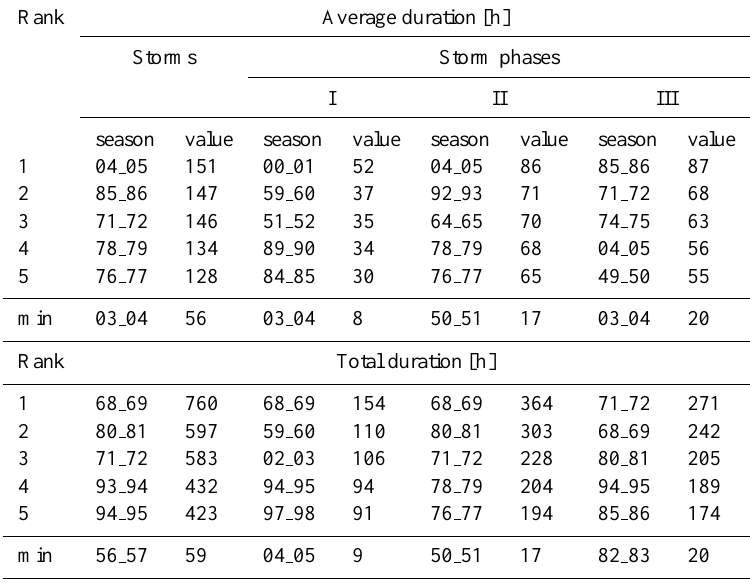
Table 1. The five most and the one least intensive storm seasons within the study period 1948–2010, ranked according to average and total storm duration proxies.